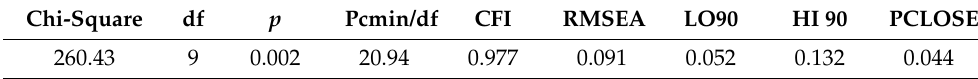
Table 2. Fit indices in Study 1.